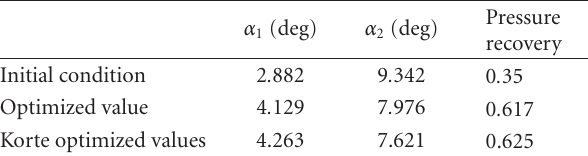
Table 2: Summary of initial and final inlet conditions.